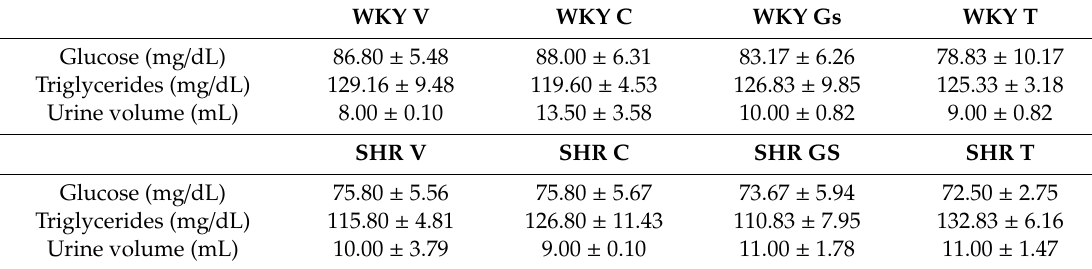
Table 4. Effects of different treatments on blood glucose, triglyceride levels and urine volumes in SHRs and WKYs.